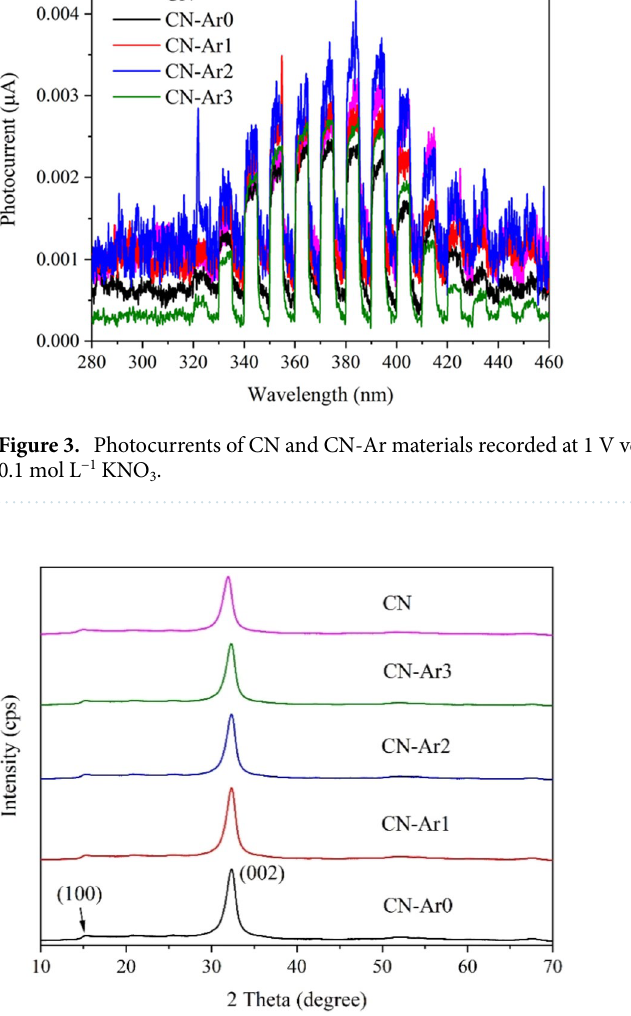
Figure 4. XRD patterns of CN and CN-Ar materials.